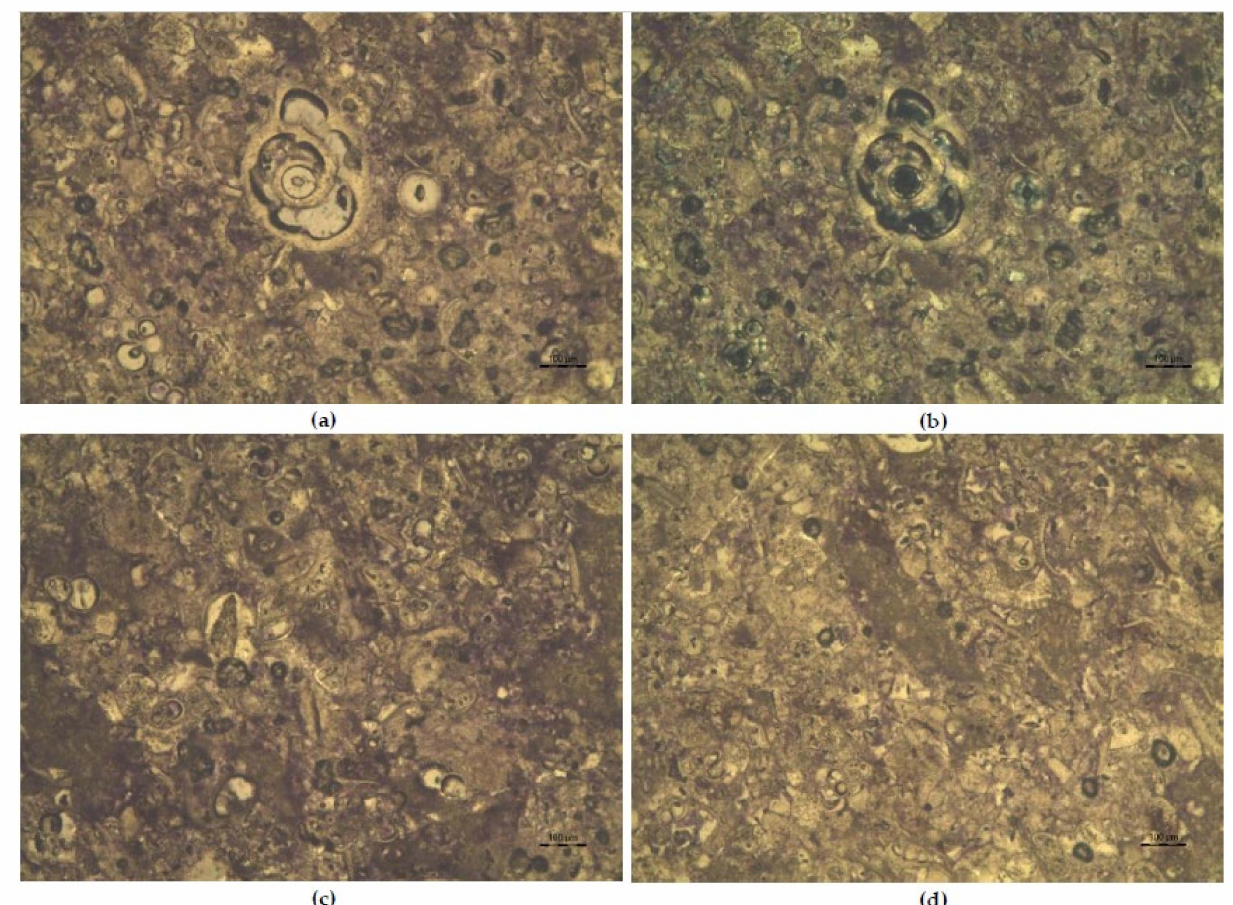
Figure 11. Sample C2: ( a ) plane-polarized light: parallel nicols, micrite matrix with planktonic Globigerina foraminifera and rare bioclasts; ( b ) cross-polarized light: same view as ( a ), inter-particle porosity; ( c ) plane-polarized light: micrite matrix with planktonic Globigerina foraminifera and bioclasts, in the central part an echinoid fragment with syntaxial overgrowth; ( d ) plane-polarized light: micrite is recrystallized to microspar and containing planktonic Globigerina foraminifers, single benthic foraminifera and bioclasts; in the central part the micrite is preserved and looks like a micrite